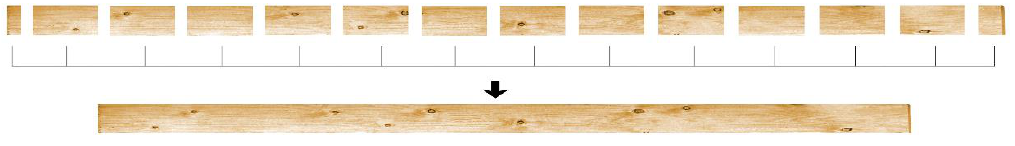
Figure 2. Process of automatic seamless splicing.